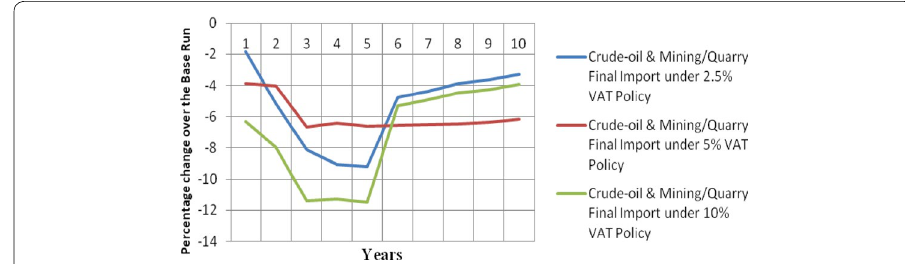
Fig. 35 Changes in crude oil/gas and mining/quarry final imports under varying VAT rates